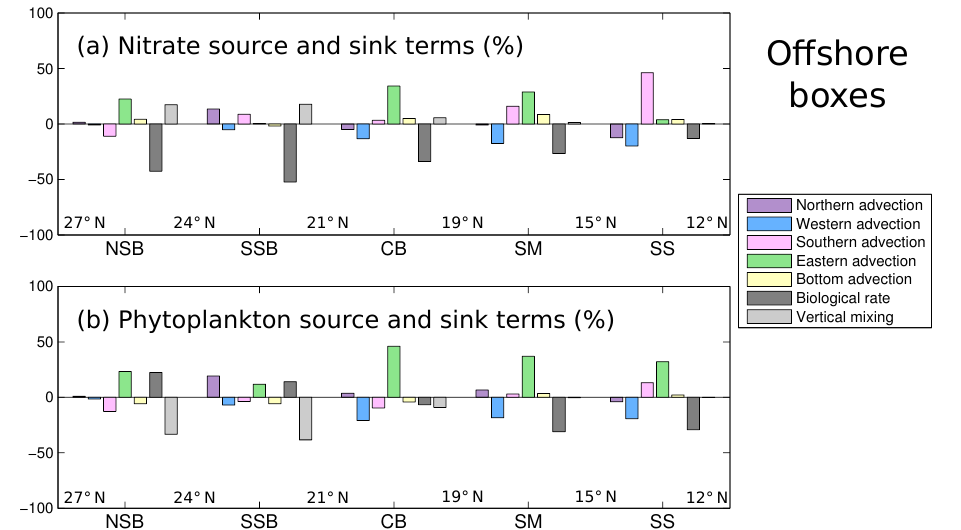
Figure 12. Spring mean (March–May) contribution of the different source and sink terms of (a) nitrate and (b) phytoplankton biomass in the offshore boxes (%, positive inward): northern, western, southern and eastern horizontal advection, vertical advection and diffusion (vertical mixing) at the bottom, and the net local biological rate of change. From north to south: northern Saharan Bank (NSB), southern Saharan Bank (SSB), Cape Blanc area (CB), Senegalo-Mauritanian region (SM) and southern Senegal region